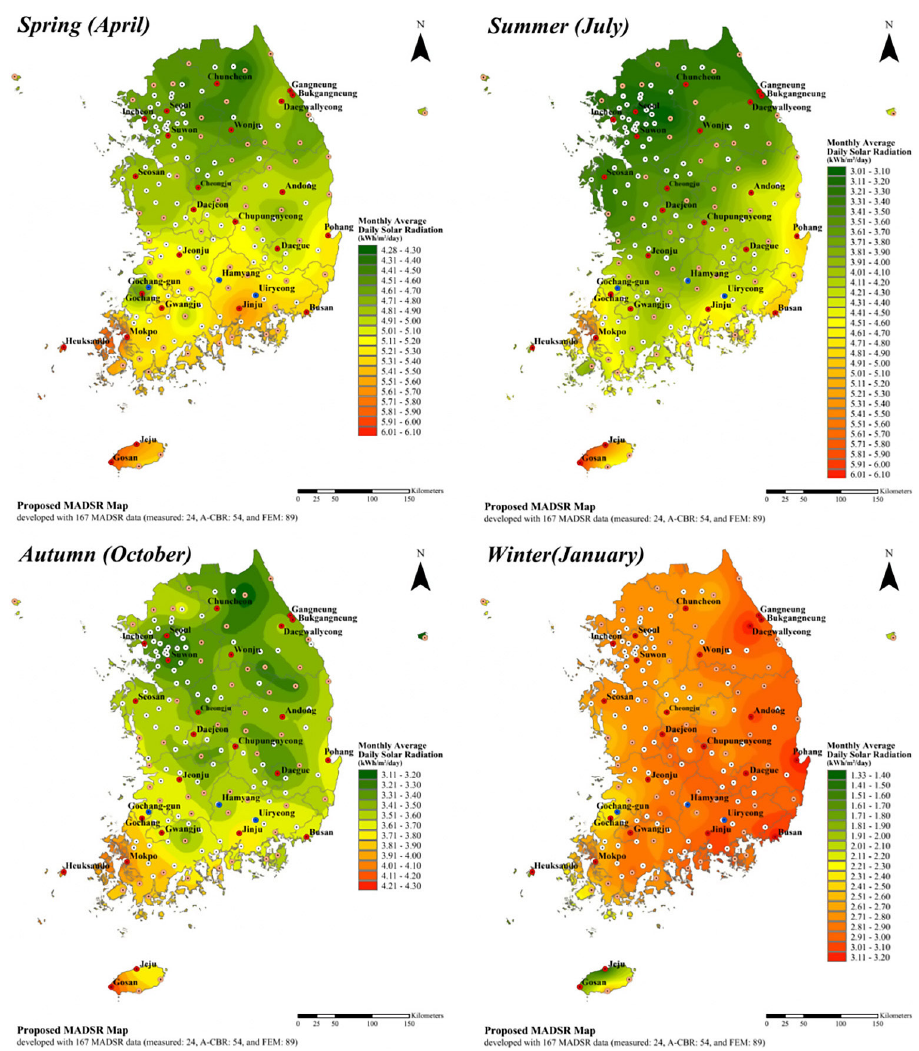
Fig. 7. The proposed MADSR map by season in South